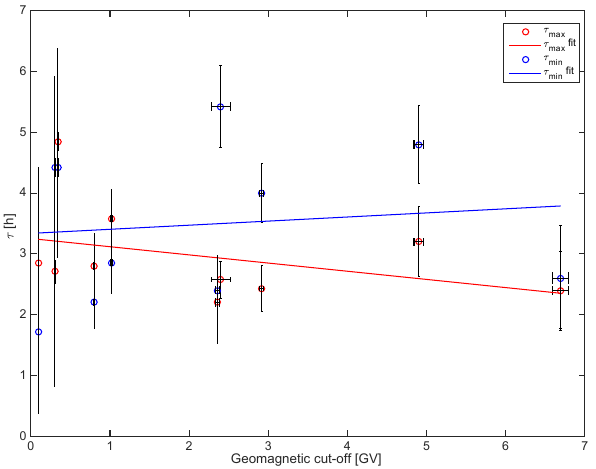
Figure 6. The amplitude of the diurnal variation at each neutron monitor as a function of the neutron monitor’s cut-off rigidity. The red line is for A< 0 polarity cycles and the blue is for A> 0 cycles. The NMs shown (from left to right) are: South Pole ( R C = 0.1GV), McMurdo ( R C = 0.3GV), Thule ( R C = 0.3GV), Oulu ( R C = 0.8GV), Deep River ( R C = 1.02GV), Kiel ( R C = 2.36GV), Newark ( R C = 2.4GV), Climax ( R C = 2.92GV), Hermanus ( R C = 4.9GV) and Alma Ata ( R C = 6.69GV). The data are shown by the circles with x and y errors shown by the black crosses. Errors on the geomagnetic cut-off rigidities are calculated from the local variations in the geomagnetic field over the time span of the neutron monitor data, whereas the error on the amplitude is the average standard error between the peak and trough of the